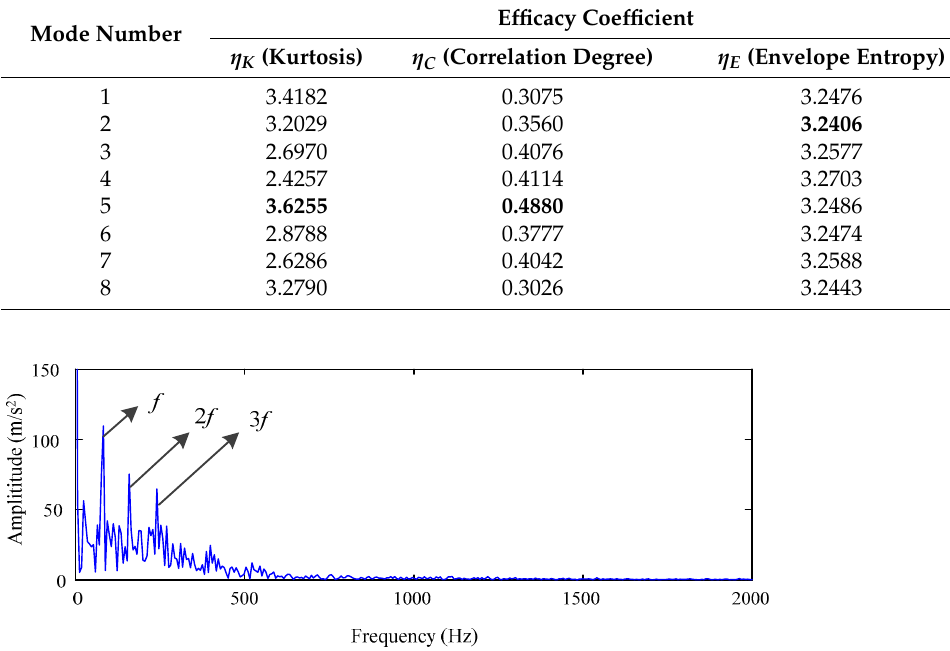
Figure 15. Envelope spectrum of optimal component by using IVMD.